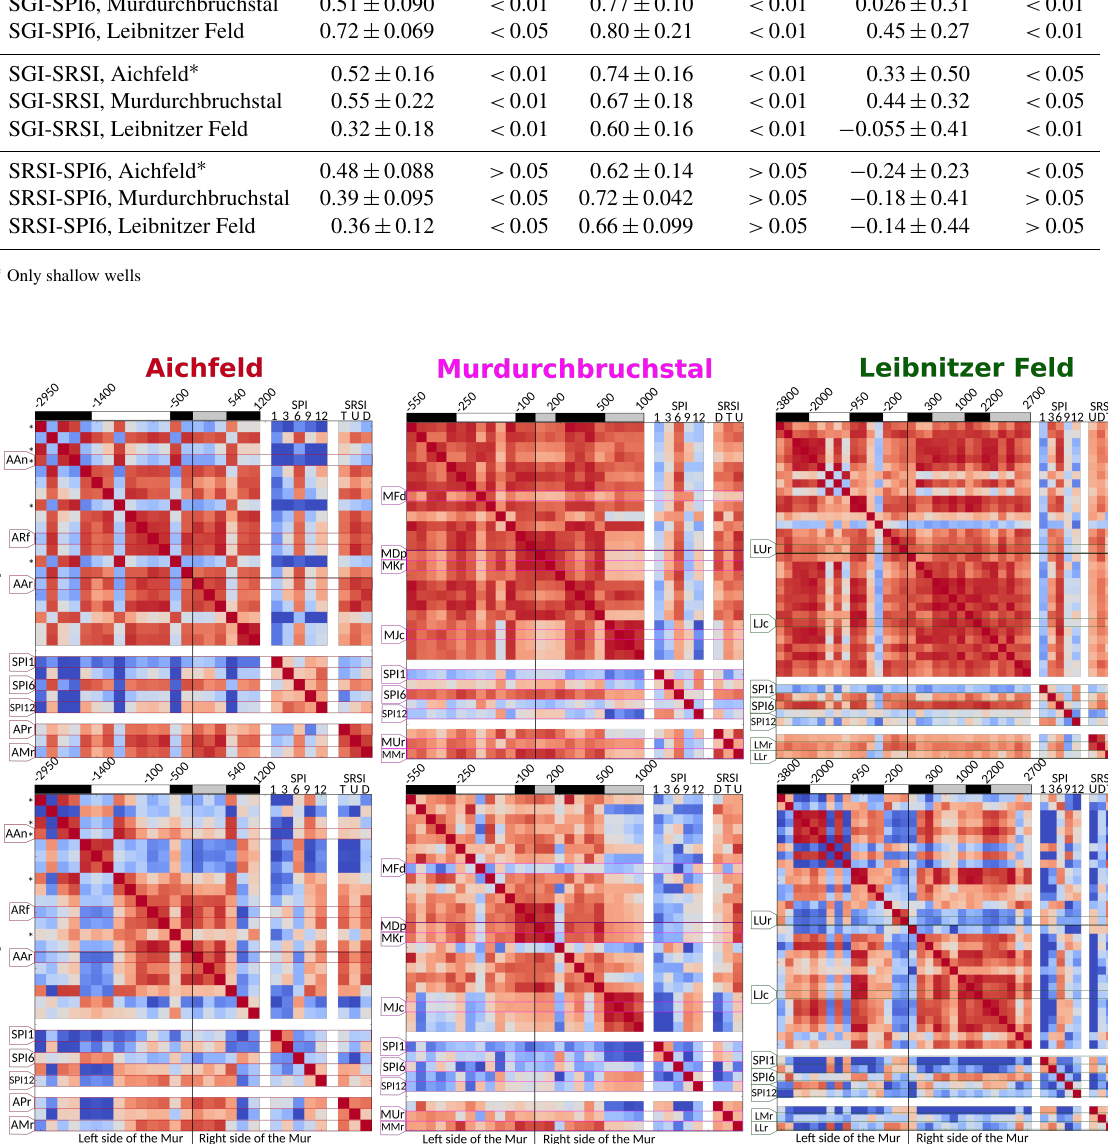
Figure 4. Correlation matrices for the three subregions, showing the effects of the snow-rich winter of 1885/86 and the snow-poor winter of 1989/90. Legend for the colors and description of the distances; see Fig.